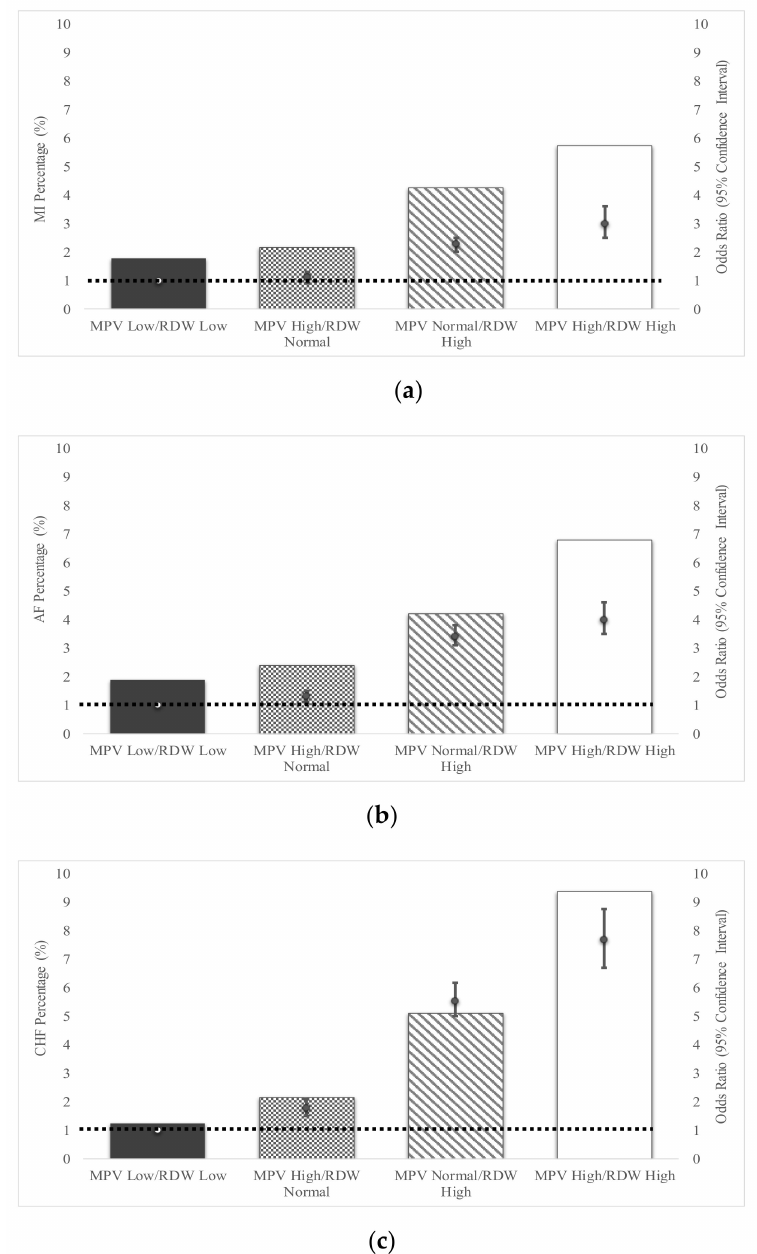
Figure 3. Percentage of Psoriasis patients exhibiting Cardiovascular Disease based on a combination of Mean platelet volume (MPV) and Red Cell Distribution Width (RDW). The percentage of cardiovascular disease; myocardial infarction (MI), ( a ), atrial fibrillation (AF), ( b ), and chronic heart failure (CHF), ( c ) based on a combination of red cell distribution width and mean platelet volume in psoriasis patients is shown along with the Odds Ratio of developing these conditions as predicted by the combined values of RDW and MPV. Odds Ratios are adjusted for age, gender and hypertension. Open circles connected by the dashed line represent the reference value (1) for each OR. Odds Ratios are represented by solid circles and error bars, which represent 95% confidence